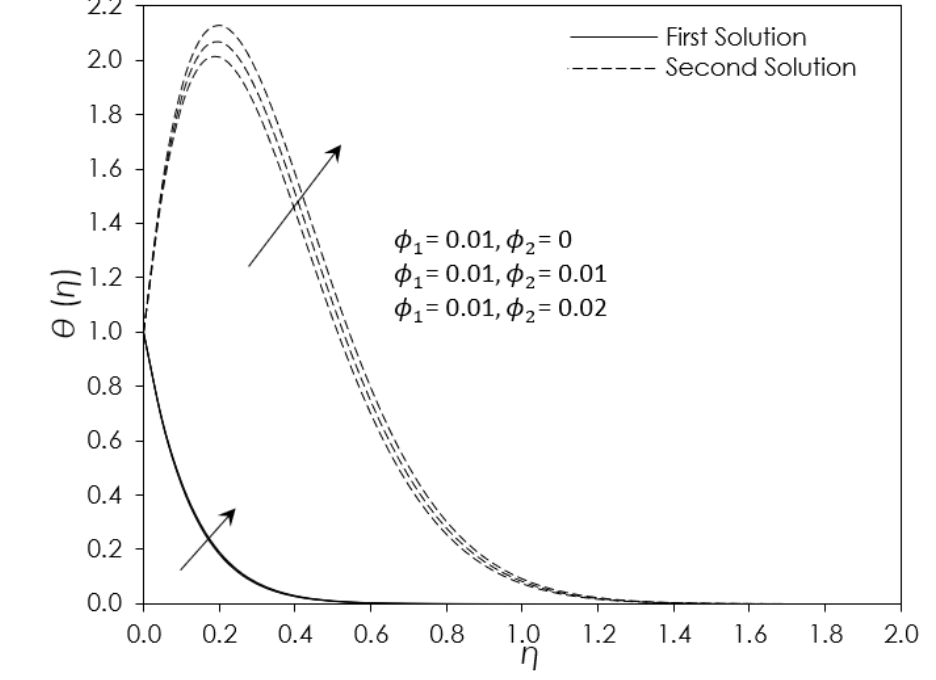
Figure 8. Variation of 𝜃(𝜂) for different values of 𝜙 2 .